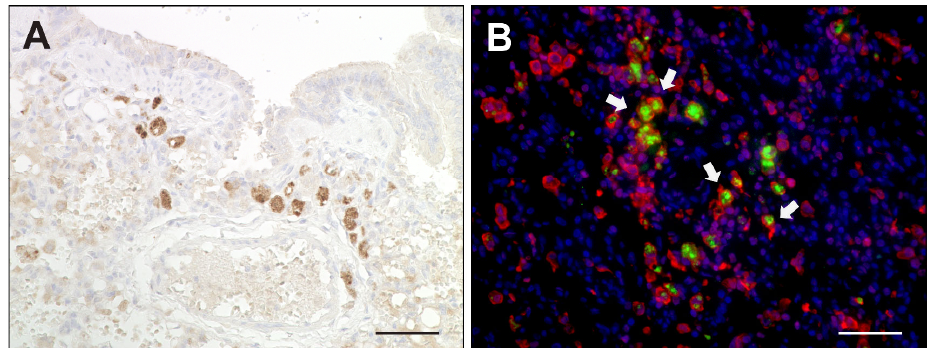
Figure 9. TNF ‐α expression in canine distemper virus ‐ infected lungs. ( A ) Detection of TNF ‐α in mononuclear cells by immunohistochemistry. ( B ) Double immunofluorescence labeling against TNF ‐α (green) and Iba ‐ 1 (red) confirmed histiocytic cells (arrows) as a source of TNF ‐α . Nuclei were counterstained with bisbenzimide (blue). Scale bars: 50 μ m.